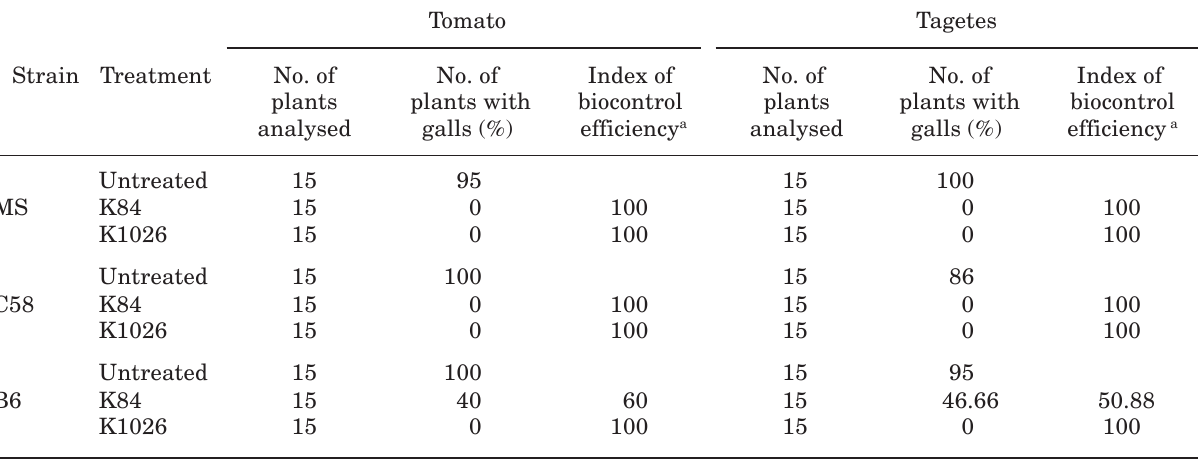
Table 4. Effectiveness of the antagonistic Agrobacterium radiobacter strains K84 and K1026 in preventing tumours on tomato and tagetes stems.